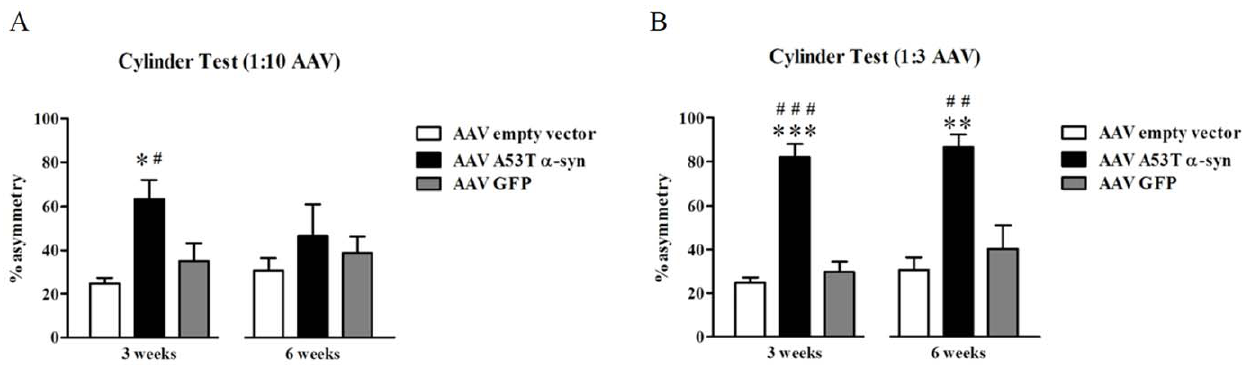
Figure 2. Forelimb asymmetry in the cylinder test. Three weeks following injection of AAV1/2 A53T a -synuclein a significant asymmetry in forelimb use is present in rats exposed to either titer of vector (1:10, 5.1 6 10 11 gp/ml [panel A] or 1:3, 1.7 6 10 12 gp/ml [panel B]). At six weeks however the rats injected with the 1:10 dilution recovered on this test (A), while the rats injected with the 1:3 dilution continued to show a behavioural impairment (B). * , ** , *** c.f. empty vector, P , 0.05, 0.01, and 0.001 respectively; # , ## , ### c.f. GFP, P , 0.05, 0.01, and 0.001 respectively.